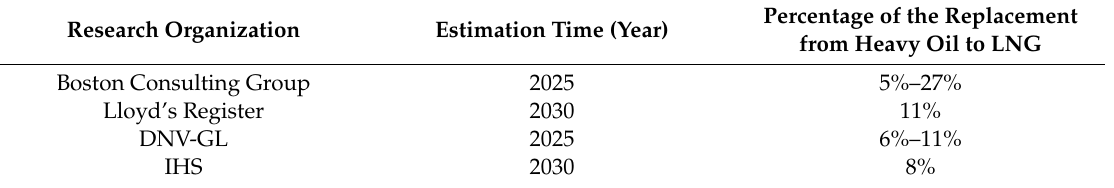
Table 1. Demand Forecast of liquefied natural gas bunkering vessels (LNGBVs).